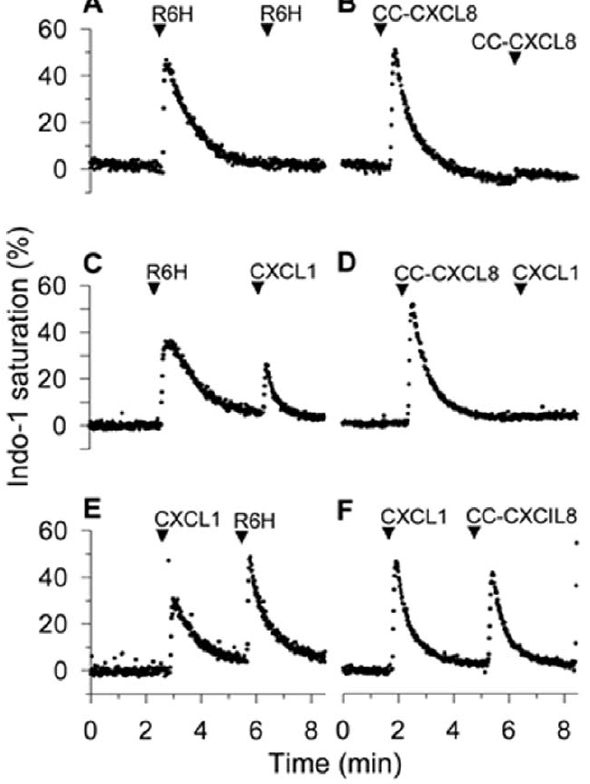
Figure 4. The R6H-CXCL8 mutant activated CXCR1 in neutro- phils. Human neutrophils loaded with Indo-1 were treated with and without 1 m M of the CXCR2 inhibitor SB225002 and stimulated with 100 nM of CXCL8 (A and D), the CXCR2 agonist CXCL1 (B and E) and the R6H-CXCL8 mutant (C and F). The record is representative of at least five independent experiments.